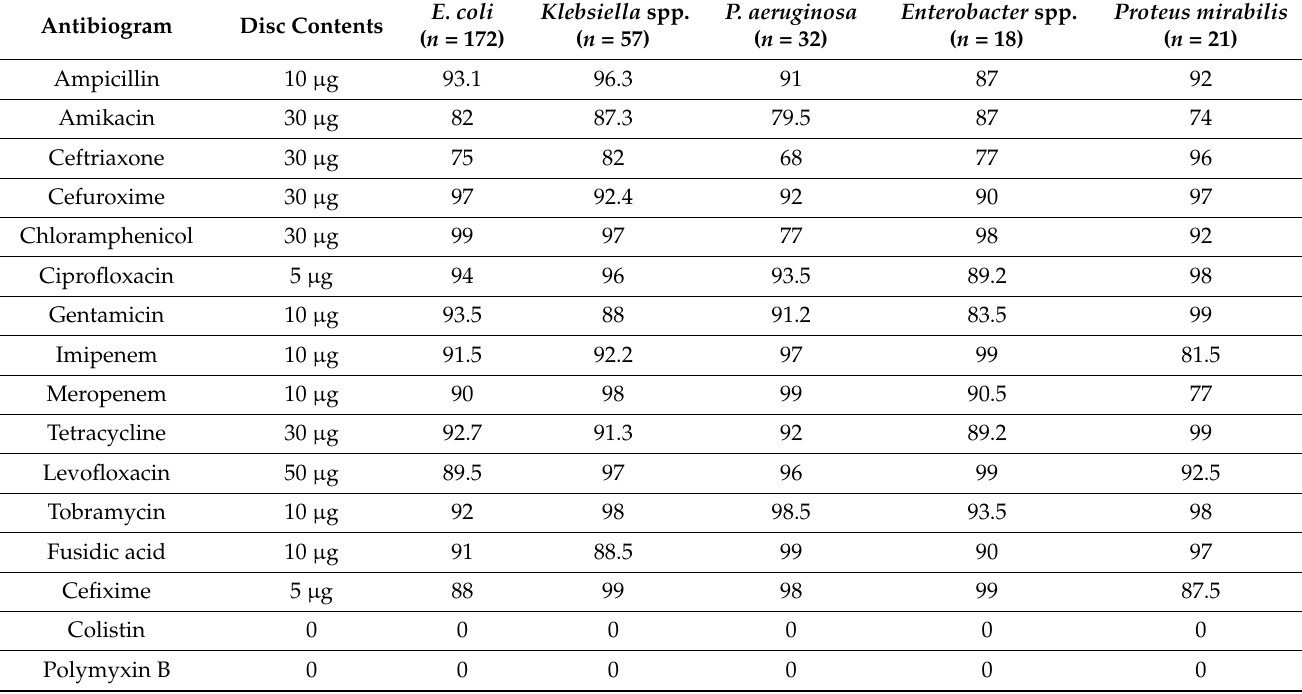
Table 2. Percentage resistance profile of clinically isolated bacteria.